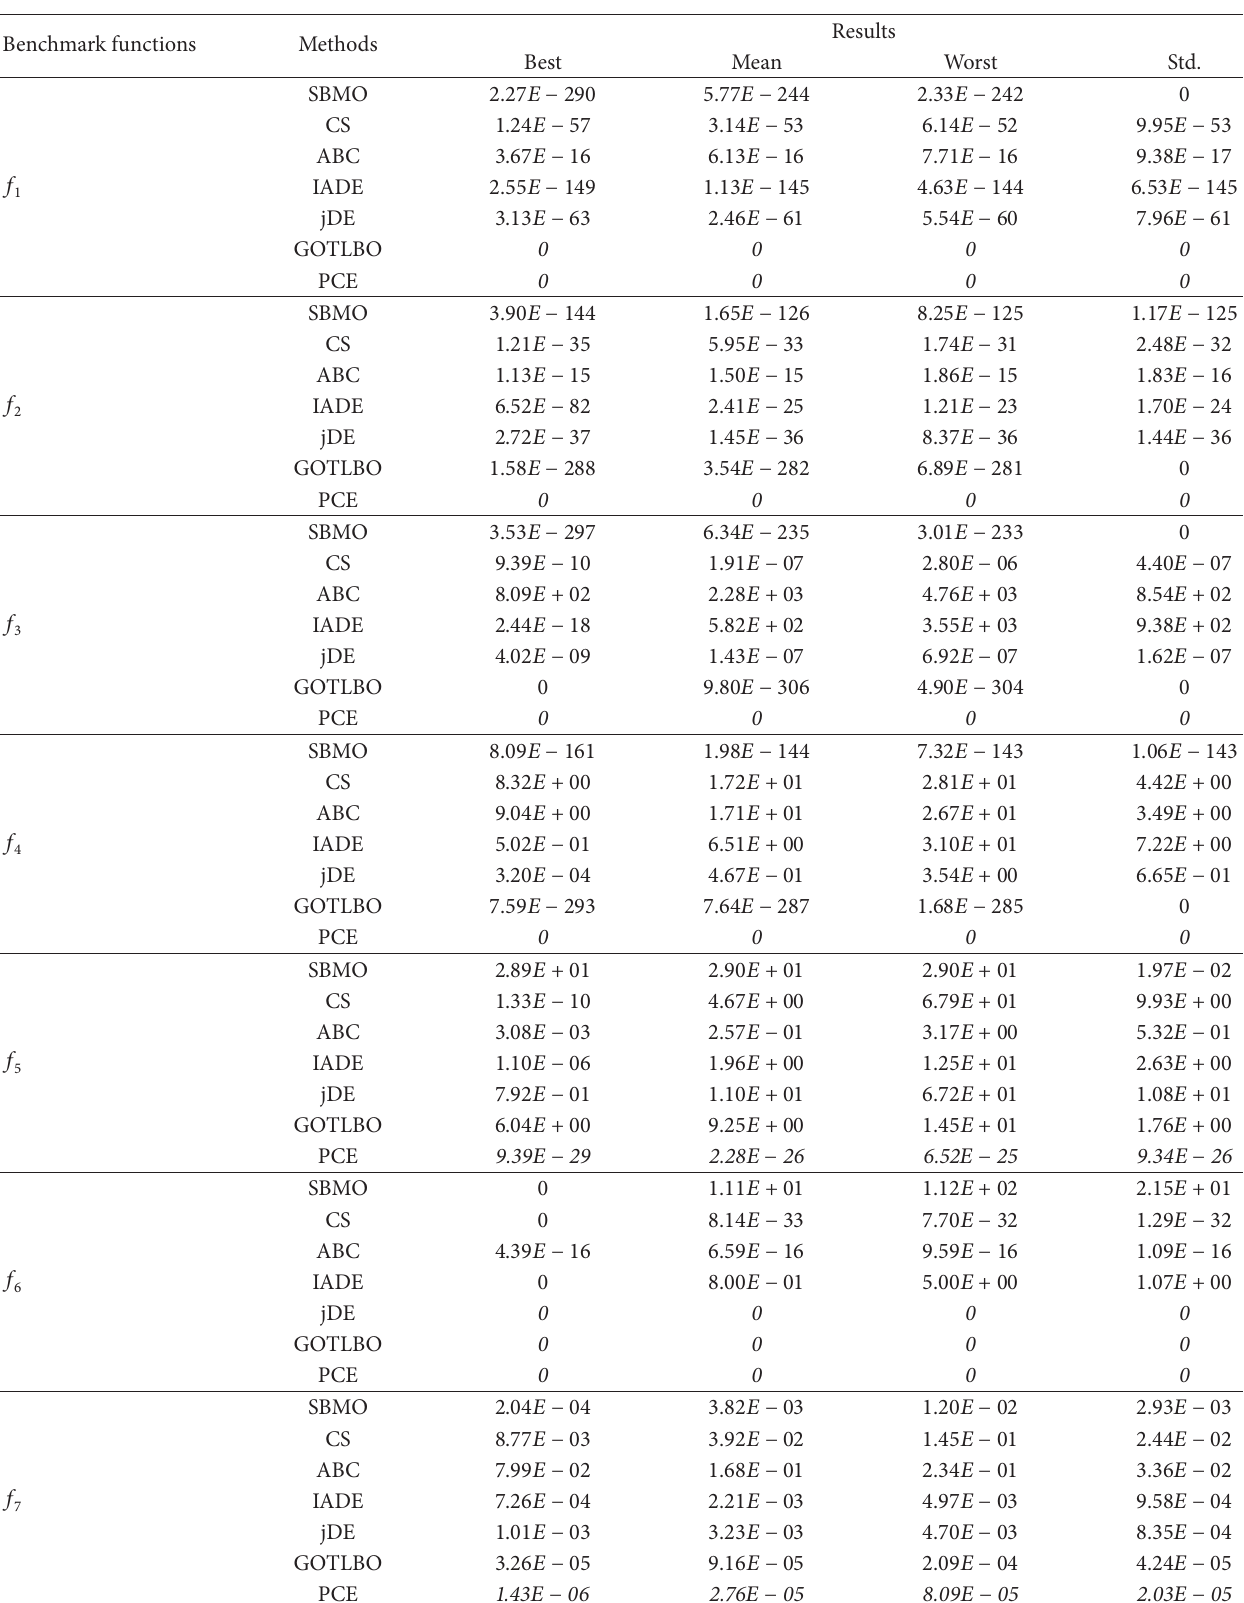
Table 3: Simulation results for 13 standard benchmark